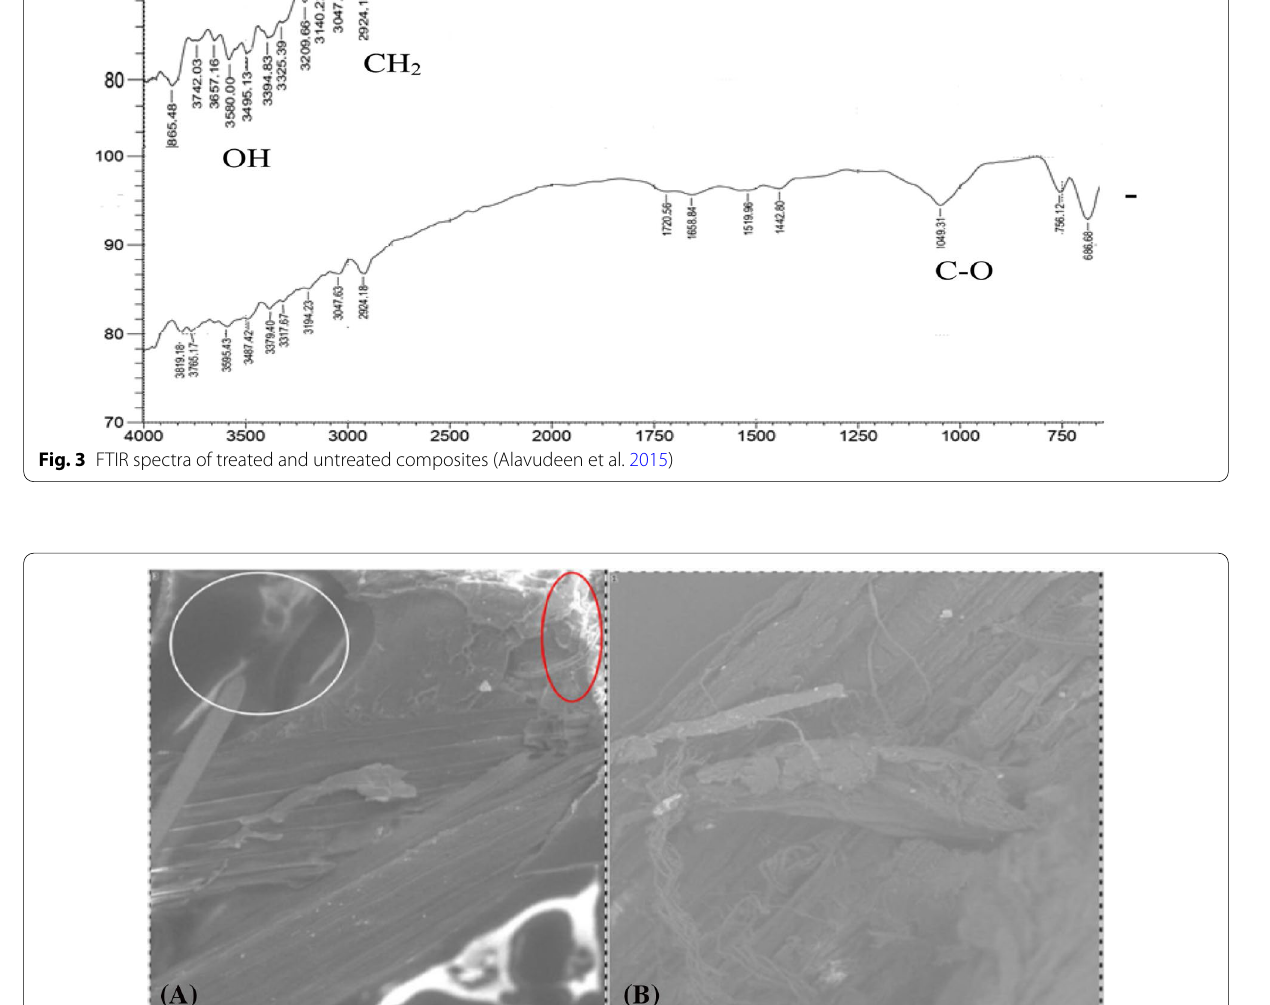
Fig. 4 SEM micrographs of a untreated and b treated composites (Alavudeen et al.